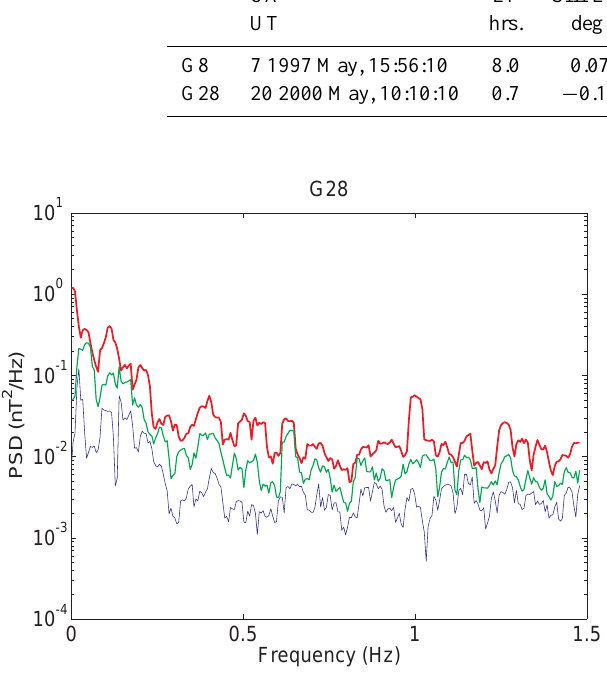
Table 1. Various parameters for the Ganymede flybys G8 and G28. The ambient plasma environment is characterized by an ion density range n i = 1 − 8cm − 3 (Kivelson et al., 2004). Listed are the time of closest approach (CA), the local time (LT) of the encounter, the System III latitude (Dessler, 1983), the B r component of the Jovian field and the dipole (centrifugal) latitude (Dip.(Cent.) Lat.), the altitude and latitude of the flyby centred on Ganymede. LT SIII Lat. Dip.(Cent.) Lat.